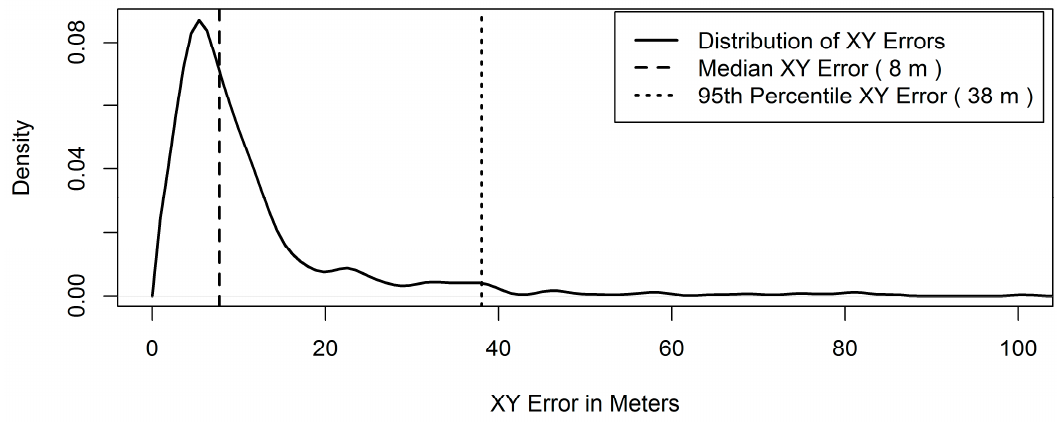
Figure 6. Distribution of horizontal plot positioning errors for SPL relative to high-precision GNSS coordinates.